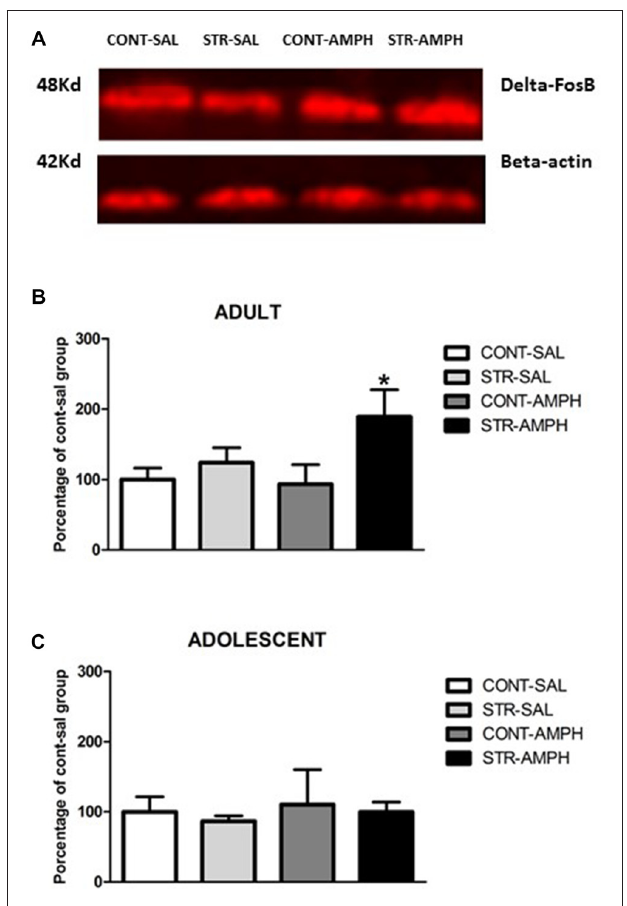
FIGURE 2 | (A) Schematic section of the rat brain, adapted from the stereotaxic atlas of Paxinos and Watson (2006), showing the location of the punches in the nucleus accumbens (Nac). (B) Representative western blotting bands of control-saline (CONT-SAL), stress-saline (STRESS-SAL), control-amphetamine (CONT-AMPH) and stress-amphetamine (STRESS-AMPH) adult animals. (C) ∆ FosB levels in response to amphetamine (1.0 mg/kg) or saline after repeated stress exposure in the nucleus accumbens of adult and adolescent rats. The bars represent mean ± SEM of 6–9 animals per group. ∗ p < 0.05 different than other